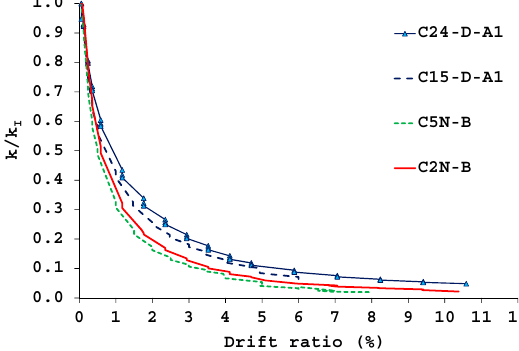
Figure 18. Stiffness degradation: specimens strengthened with the systems “type B” and “type A1”.